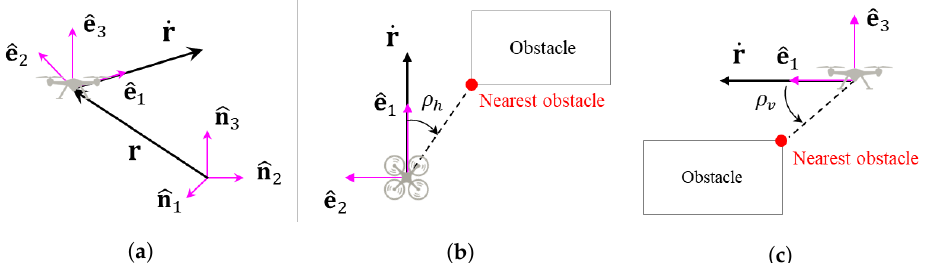
Figure 3. Definitions of ( a ) E frame and relative angles between the quadcopter and the nearest obstacle in ( b ) horizontal and ( c ) vertical planes. Table 1. Criteria for rotation matrices to determine the avoidance